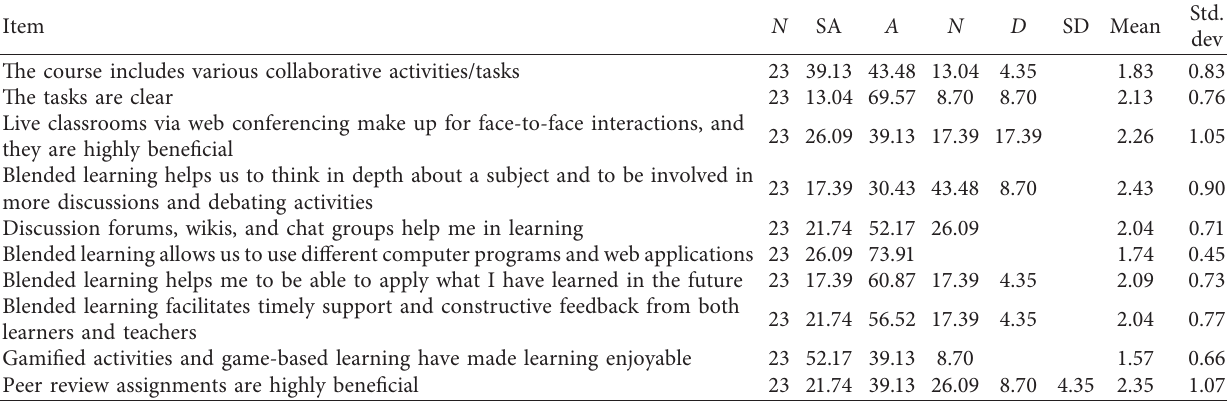
Table 5: Responses towards the activities and resources of the syllabus.